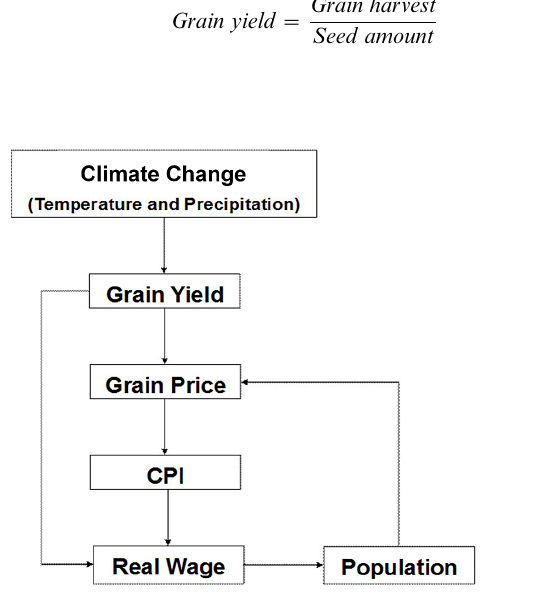
Figure 1. Conceptual Model of Climate Change and Macro- Economy Cycles in Pre-Industrial Europe. Note: The arrows should be read as: ‘‘Change in X is associated with change in Y ’’.